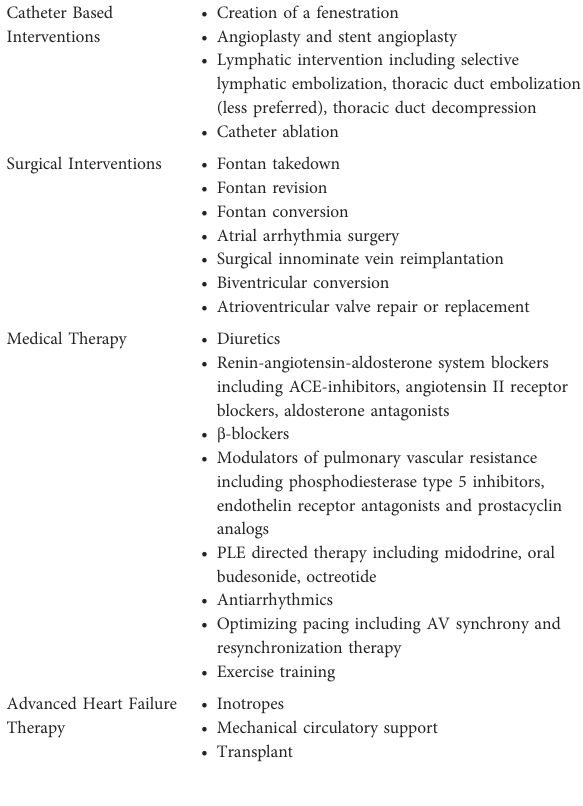
TABLE 2 Management strategies for Fontan circulatory failure. Catheter Based